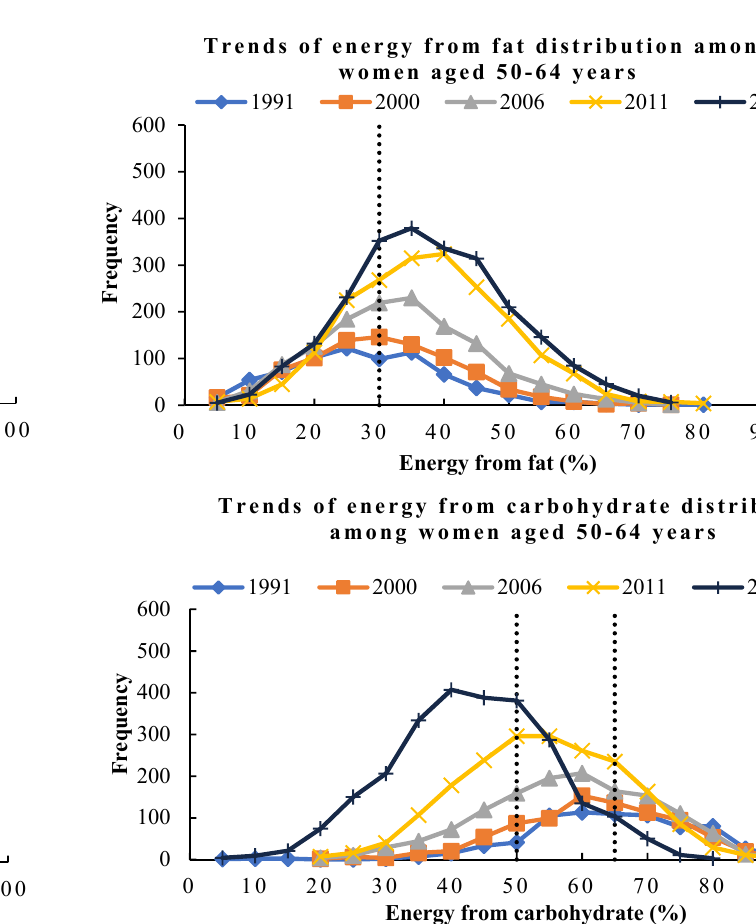
Figure 3. Shift in distribution of energy from fat and carbohydrate in Chinese adult females aged 18–64 years from 1991 to 2015.